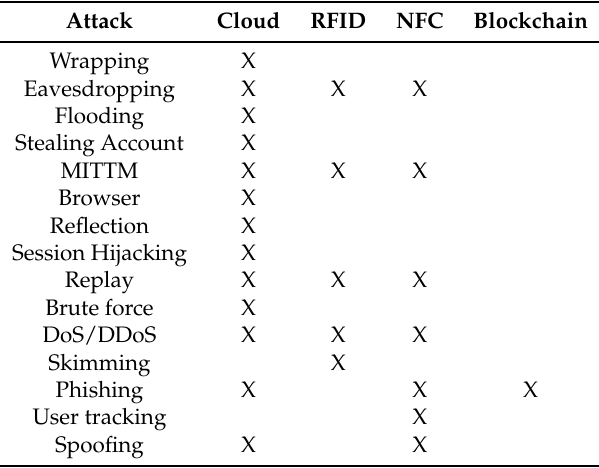
Table 1. Vulnerability comparison.